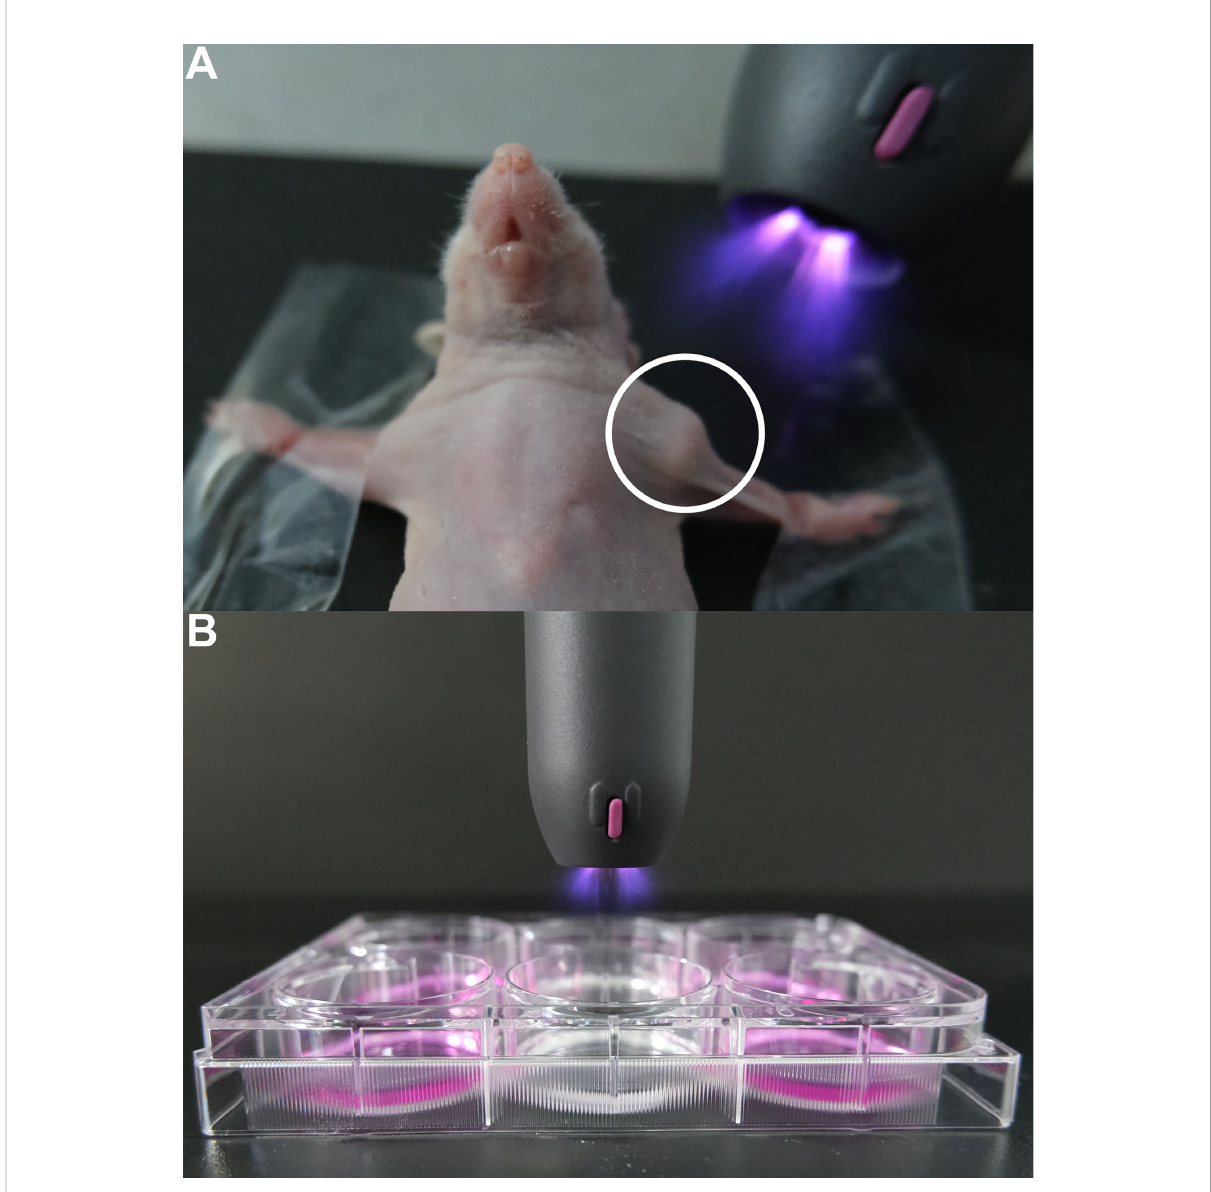
FIGURE 1 Examples of the direct and indirect applications of CAP in HNC plasma oncology. The portable Piezobrush CAP system is used for illustration. (A) Direct treatment of human tumor CDX model using CAP (the circle highlights the implanted tumor in an immunode fi cient mouse). (B) Indirect treatment of HNC cell culture in various media. (CAP, cold atmospheric plasma; CDX, cell line-derived xenograft; HNC, head and neck